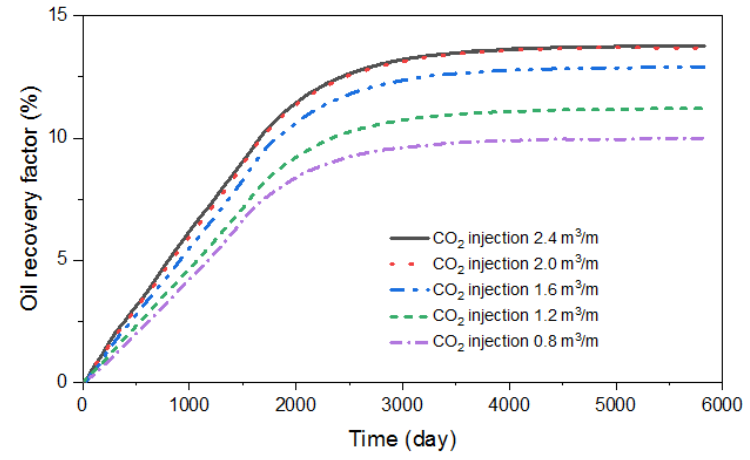
Figure 9. The comparison of oil recoveries under different CO 2 injection volumes.